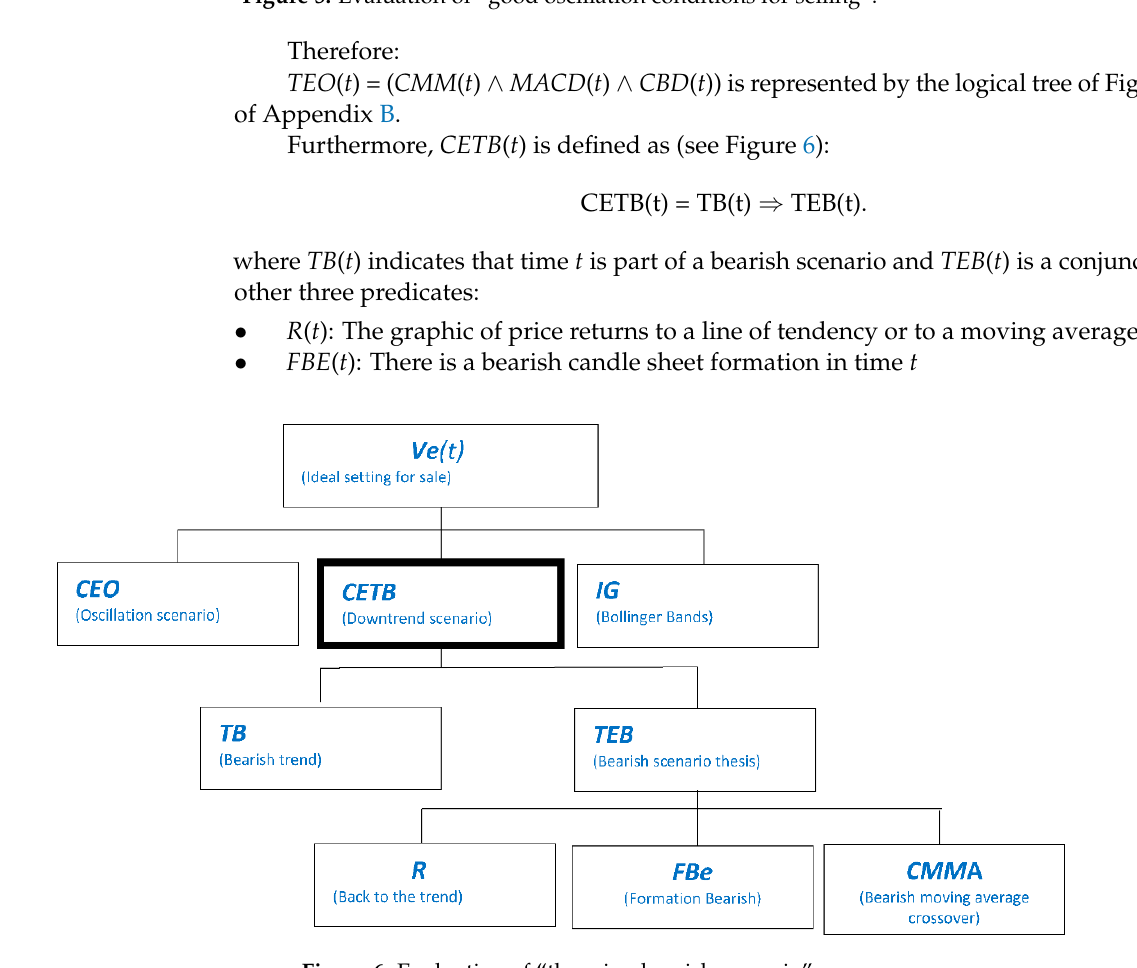
Figure 6. Evaluation of “there is a bearish scenario”. CMMA ( t ): moving average crosses the price graphics close to time t